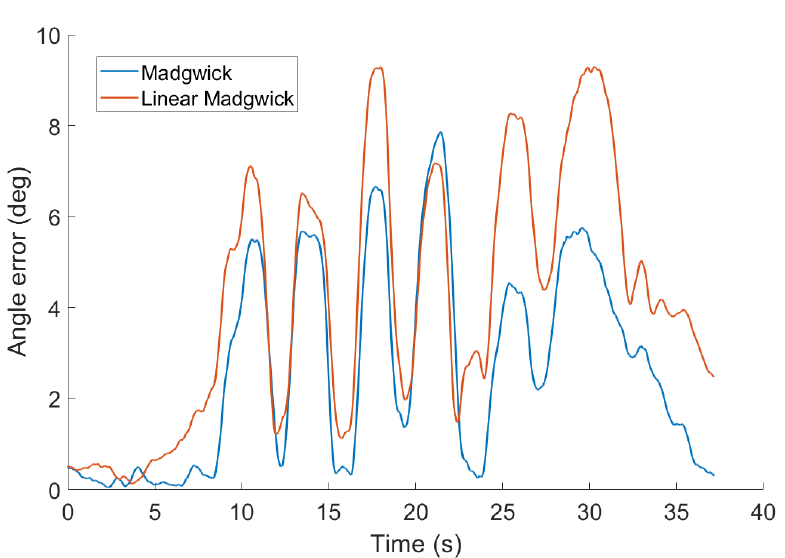
Figure 5. Comparison of accuracy of Madgwick’s filters for two choices of the correction function on the data from the first scenario. Parameters of all filters were tuned for the best overall